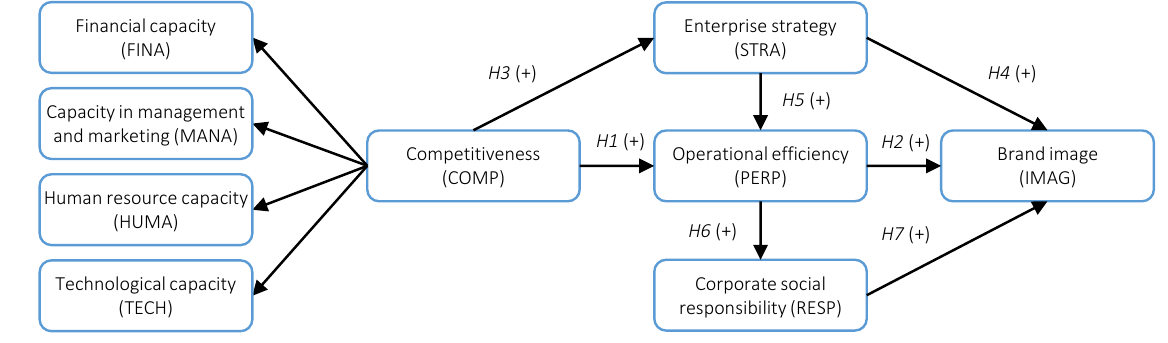
Figure 1. Conceptual research